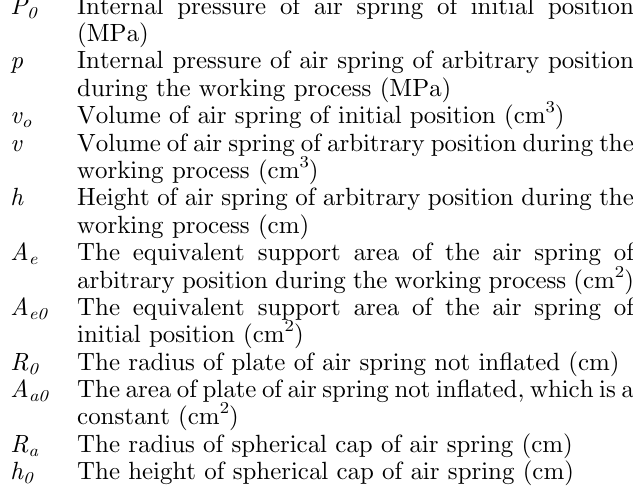
(comfor Table vs. uncomfor Table) on sleep quality through polysomnography and skin temperature,